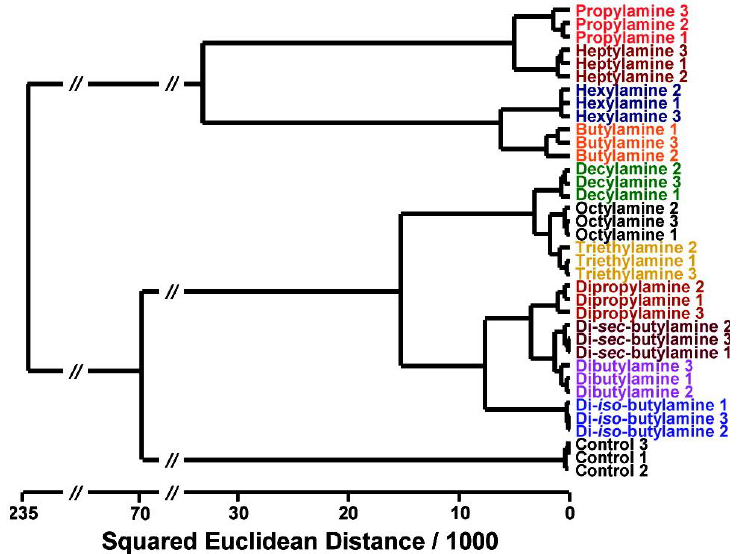
Figure 2. Dendrogram HCA (Hierarchical Cluster Analysis) for 11 structurally similar aliphatic amines using Ward’s method. No misclassifications were observed among the 36 trials. All experiments were run in triplicate